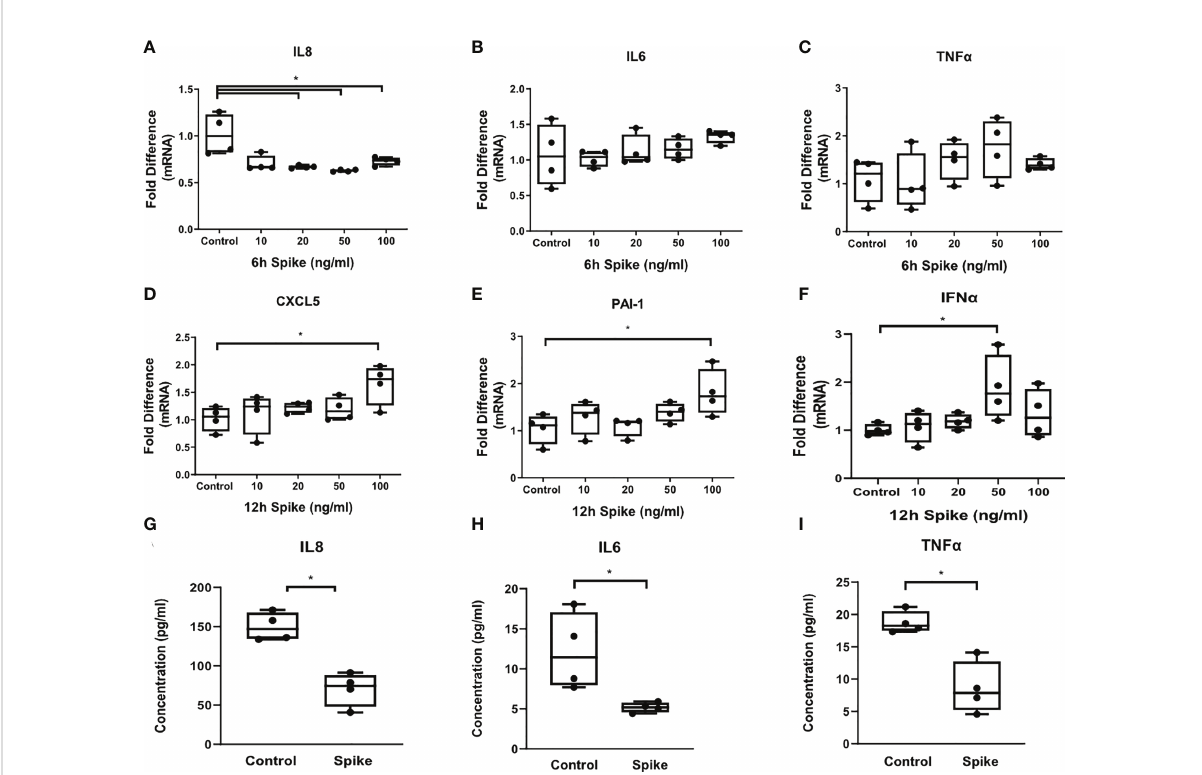
FIGURE 2 SARS-CoV-2 S protein differentially modulated TLR responses in A549 cells. A549 cells were treated with different concentrations of SARS-CoV- 2 Spike-Membrane recombinant fusion protein (10, 20, 50, 100 ng/ml) and PAM3csk4 (1 m g/ml) for 6 or 12 hours. (A) Decreased mRNA expression of IL8 was observed upon co-stimulation with SARS CoV2 S protein and PAM3csk4, compared to cells treated with PAM3csk4-alone (control). (B, C) No effect was observed for the expression of IL6 and TNF a . (D – F) Increased expression of CXCL5, PAI-1 and IFN a at 12 hours post-stimulation. (G – I) Secretion of IL8, IL6 and TNF a decreased in the presence of SARS-CoV-2 S (50ng/ml) after 12 hours. Data are illustrated in box-and-whiskers and plotted as median with range (n=4 biological replicates per group). Statistical analysis was performed with Kruskal - Wallis test (A – F) and Mann – Whitney U test (G – I) . Results are representative of three independent experiments. *p <